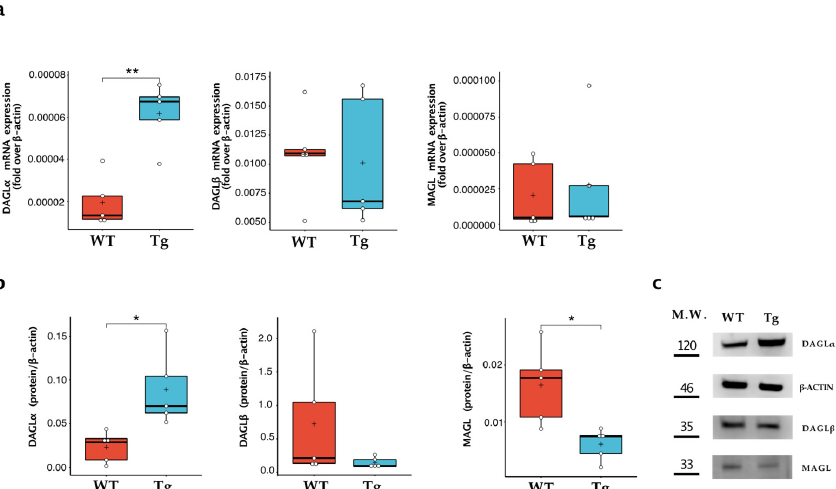
Figure 2. Characterisation of 2-AG metabolic enzymes in wild-type microglia (WT) and Tg2576 microglia (Tg). Enzymes of synthesis (i.e., DAGL α and DAGL β ) and degradation (i.e., MAGL) were quantified ( a ) for their mRNA content by quantitative real-time polymerase chain reaction and ( b ) for their protein expression by Western blot analysis. Horizontal line and + within the rectangle (boxplot) represent the median and the mean, respectively, of the values of five independent experiments (white circles). Significance is shown as a p value, calculated using an unpaired t -test. * p < 0.05; ** p < 0.01. ( c ) Representative immunoblot showing the expression of the indicated